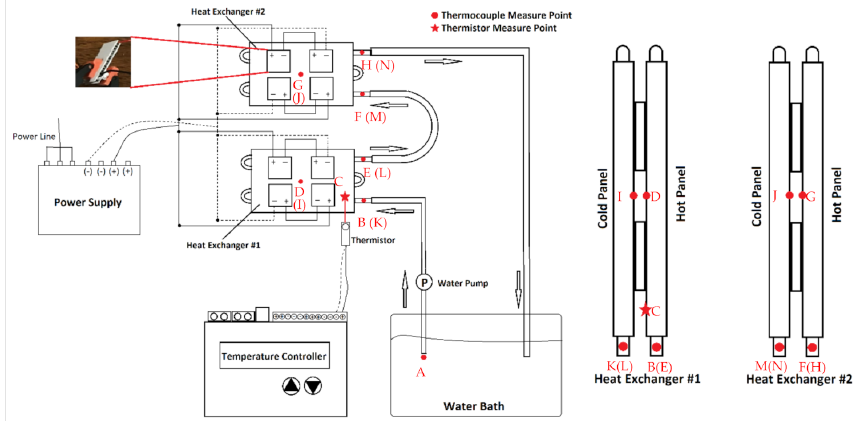
Figure 3. Experiment design (Points A-N: Measurement sensors’